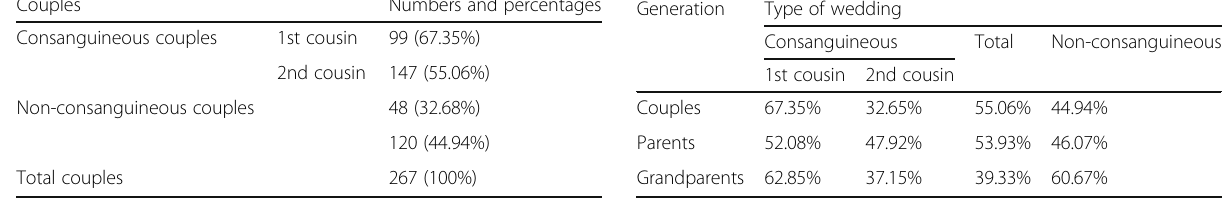
Table 1 Distribution of consanguinity in the population of Beni Abbes Couples Numbers and percentages